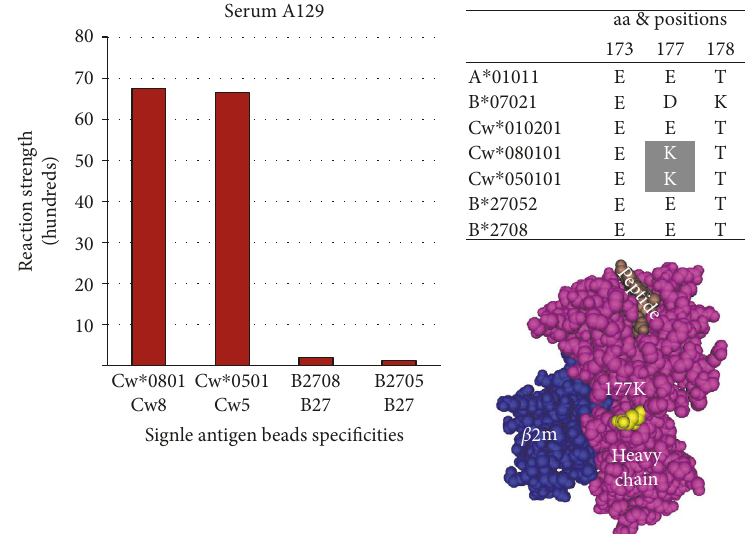
Figure 7: Epitope 40 shared by the C-locus antigens Cw ∗ 0801 and Cw ∗ 0501 and de fi ned by